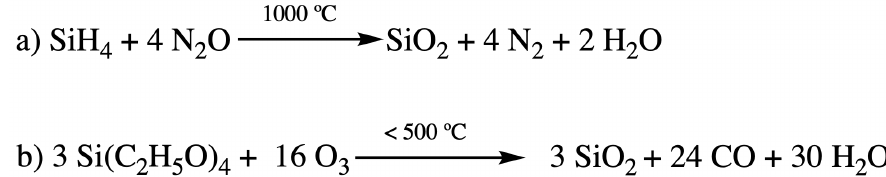
Figure 1. Deposition of SiO 2 insulating layer with silane ( a ) and TEOS ( b ).